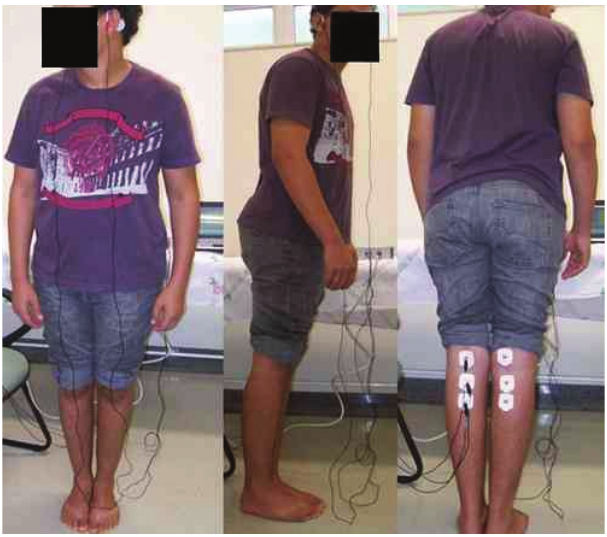
Figure 1 Electrode positioning and subject’s posture during examination.